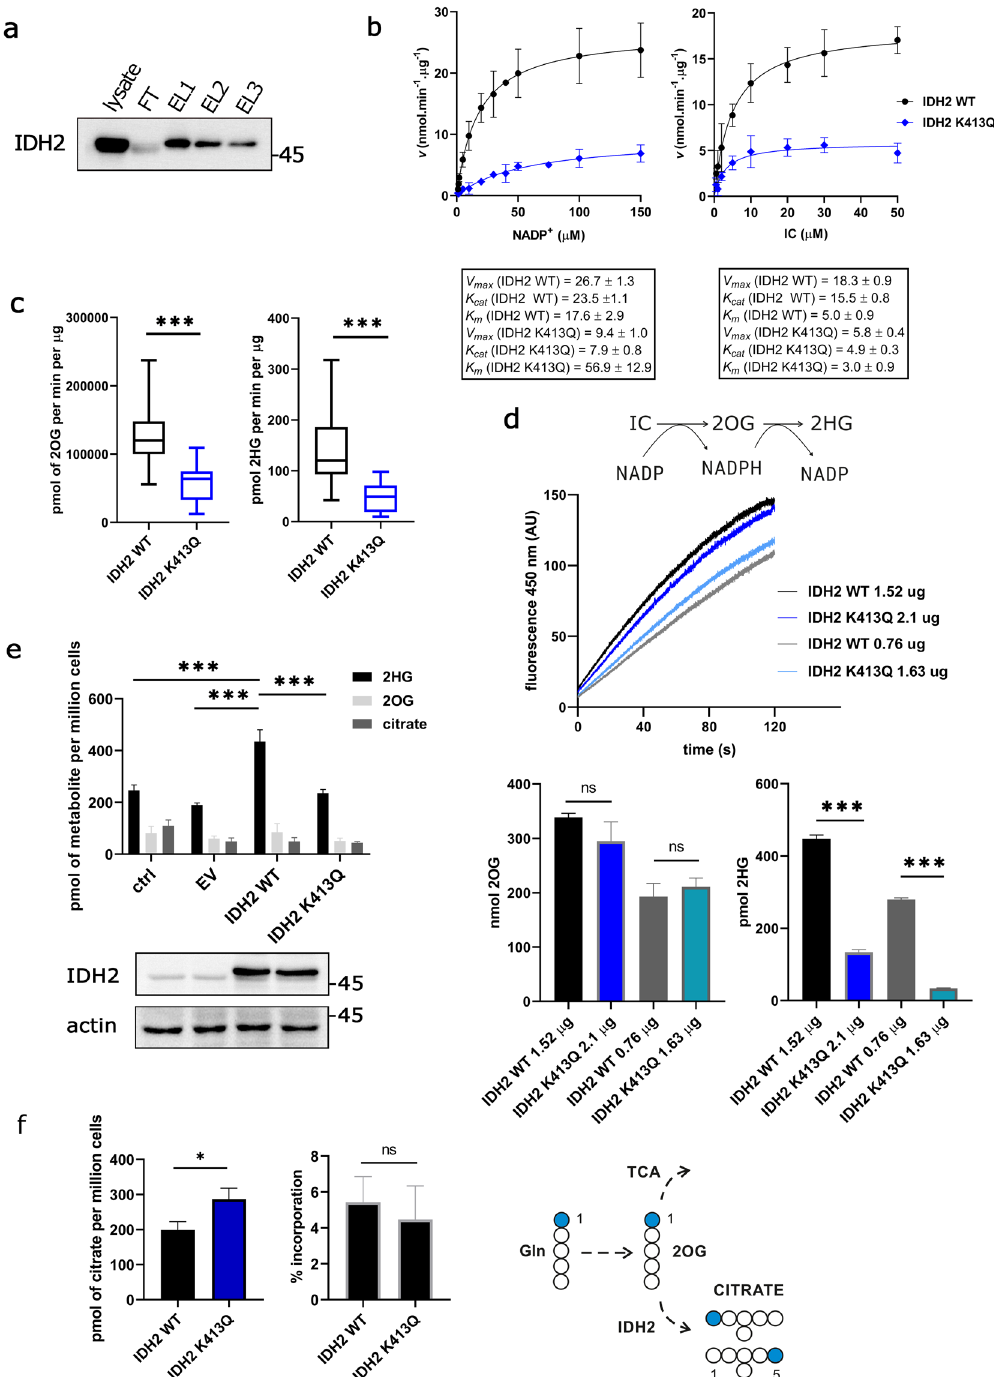
Figure 1. IDH2 reaction of IDH2 WT and IDH2 K413Q. (a) Western blot of the exemplar purification of IDH2; whole cell lysate ( lysate ), flow-through ( FT ) indicating that significant pool of IDH2-Flag is attached to the resin; three sequential steps of elution by Flag-peptide ( EL1 , EL2 , EL3 ). (b) Michaelis-Menten plots for NADP + -driven IDH2-mediated NADPH formation as dependent on concentrations of NADP + (left) and IC (right). Box contains values of V max and K m . Unit of K cat for IDH2 WT/K413Q is s − 1 . Data are expressed as mean ± s.e.m. (c) GC-MS evaluation of reaction products after 120 s of a purified enzyme in the reaction mixture, 2OG (left) and 2HG (right). N > 10, *** p < 0.0001 calculated using Unpaired t-test with Welch´s correction. (d ) Reaction schema depicting 2HG formation in the in-vitro reaction; reactions of isolated IDH2 WT and K413Q as recorded by NADPH formation depicting similar reaction rates; underneath, 2OG and 2HG evaluation of the actual reaction products corresponding to presented reaction rates. N = 3, *** p < 0.0001 calculated using One Way ANOVA Tukey´s multiple comparisons test. (e) GC-MS evaluation of metabolites 2HG, 2OG and citrate extracted from the 293LTV cells transfected with no vector (“ctrl”), with the empty vector (“EV”), with vector encoding wild-type IDH2 (“IDH2 WT”) or K413Q mutant (“IDH2 K413Q”)